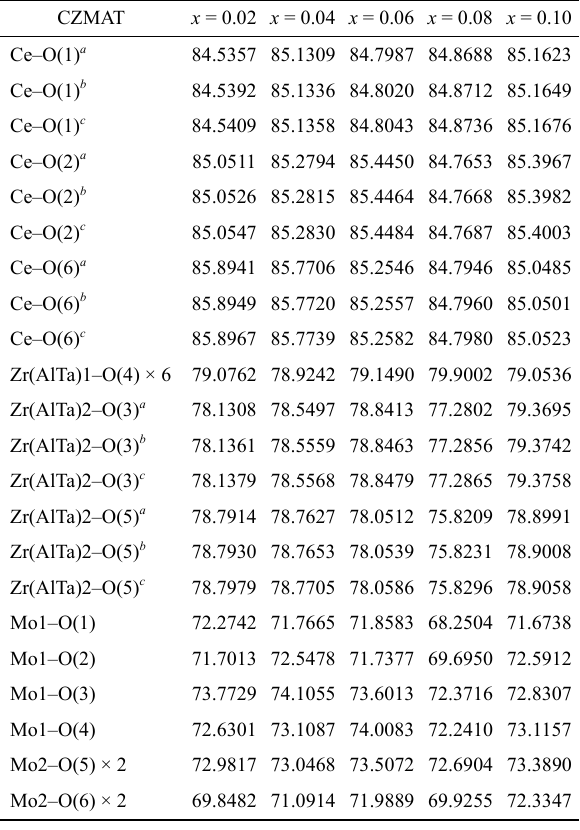
Table 3 Bond iconicity f i of CZMAT ceramics sintered at densification temperature for 6 h